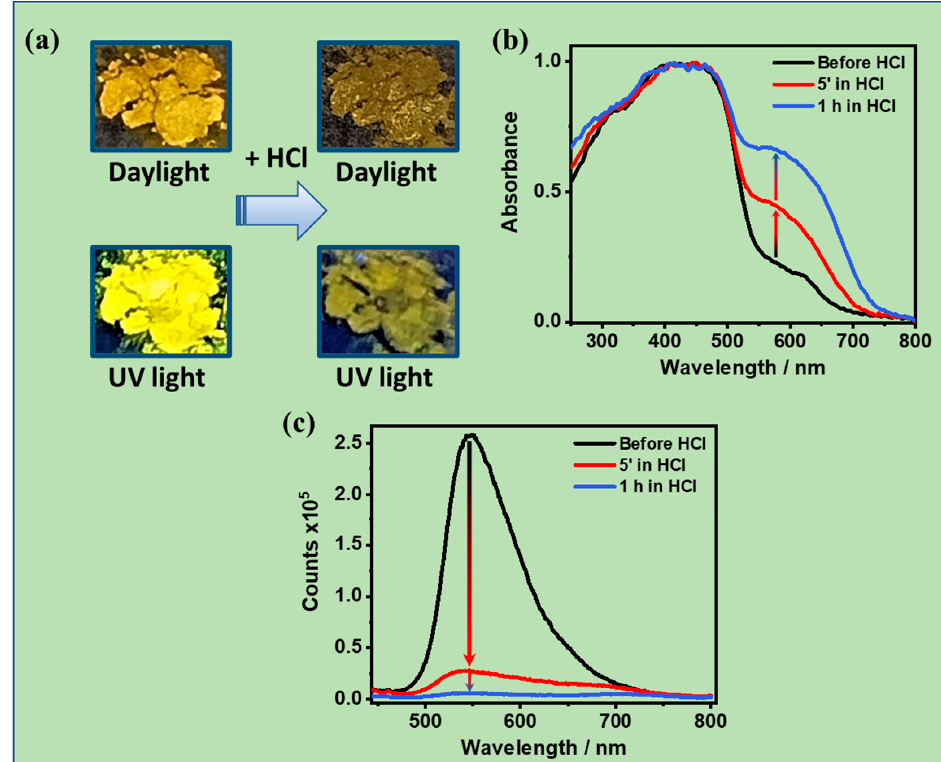
Figure 12. Acid responsiveness of ThiaHAT-1. ( a ) Photographs of the crystalline powder before (left) and after (right) being exposed to HCl under daylight (top) and UV light (365 nm, bottom). ( b ) Absorption and ( c ) emission spectra of ThiaHAT-1 before and after being exposed to vapors of HCl.